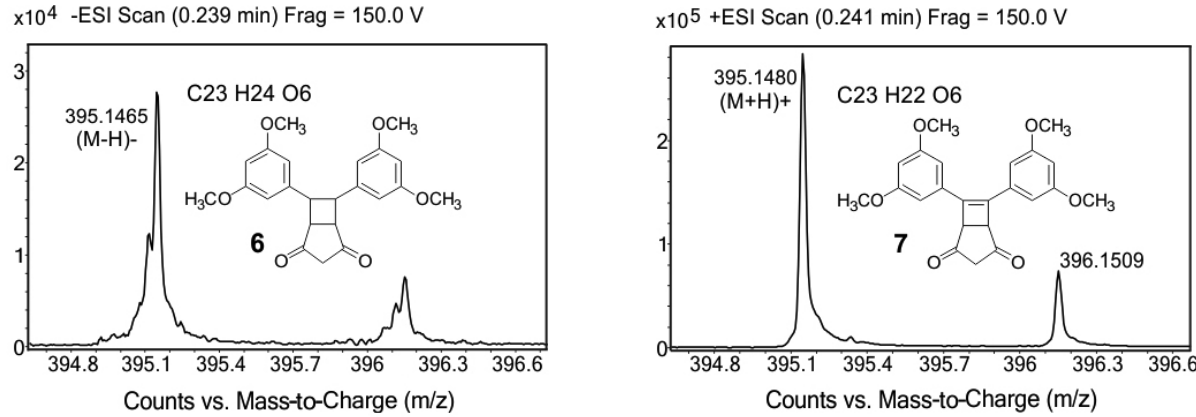
Figure 6. HRMS-ESI spectrum of the crude reaction mixture of 1f after irradiation showing characteristic signals of the intramolecular [ 2 + 2 ] cycloadduct ( 6 ) and its oxidized product 7 .